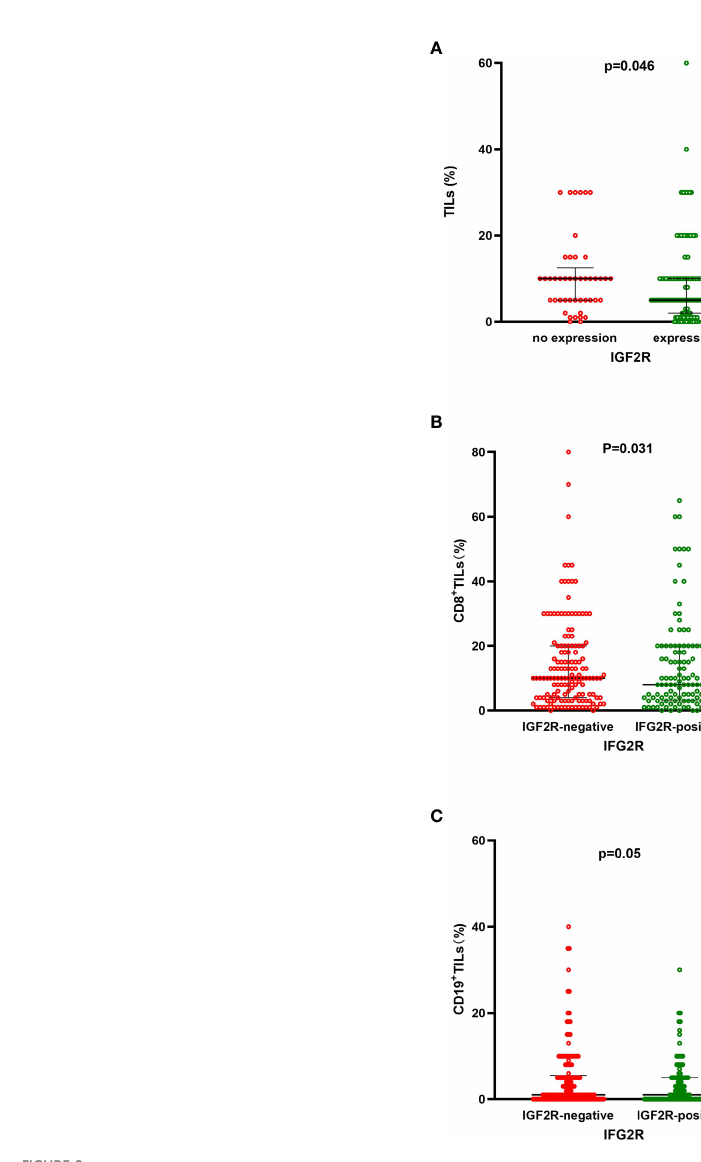
FIGURE 8 (A) Frequencies of TILs between IGF2R-negative expression and IGF2R-positive expression patients in the TNBC cohort. (B) Frequencies of CD8 + TILs between IGF2R-negative expression and IGF2R-positive expression patients in the TNBC cohort. (C) Frequencies of CD19 + TILs between IGF2R-negative expression and IGF2R-positive expression patients in the TNBC